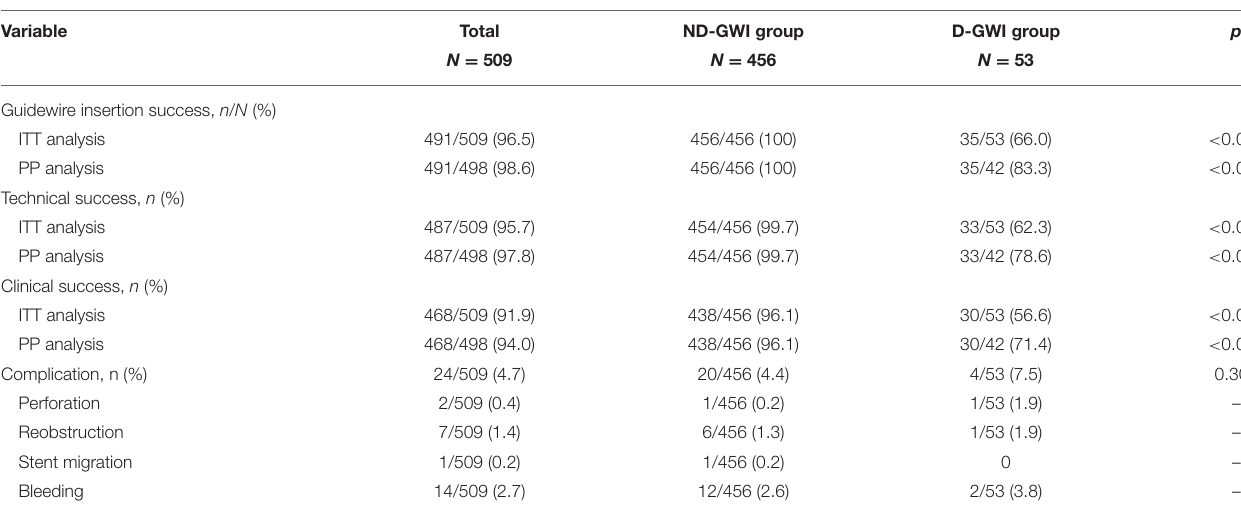
TABLE 2 | Clinical outcomes of self-expandable metal stent